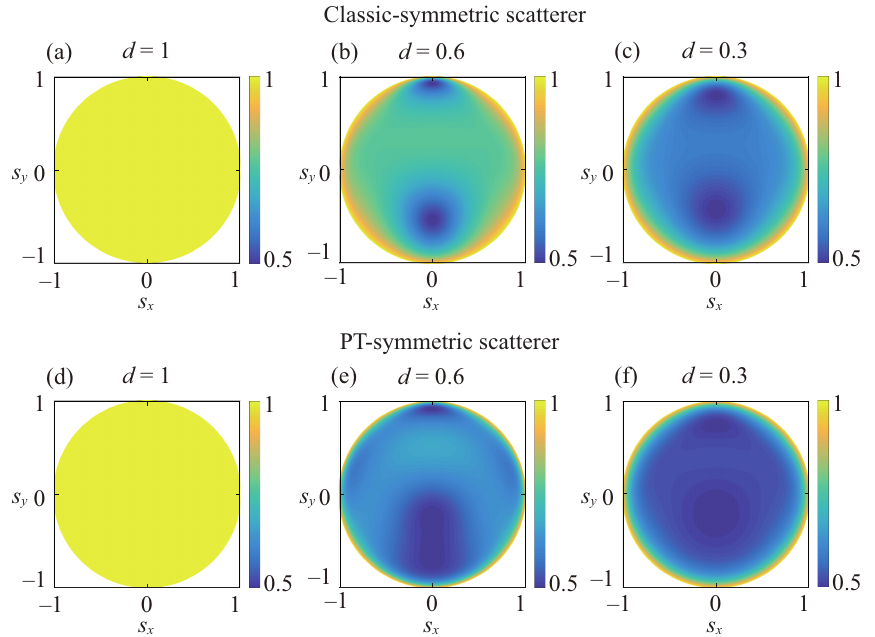
Figure 9. Simulation results for the 3D degree of polarization of the far-zone scattered field by a four-point scatterer having ( a – c ) classic-symmetric potential and ( d – f ) PT-symmetric potential. The incident beam is a partially coherent radially polarized beam with the degree of coherence showing in Equation (39). The coherence parameter in ( a , d ) is d = 1, in ( b , e ) is d = 0.6, and in ( c , f ) is d = 0.3 with d = β 1 = α 2 = β 3